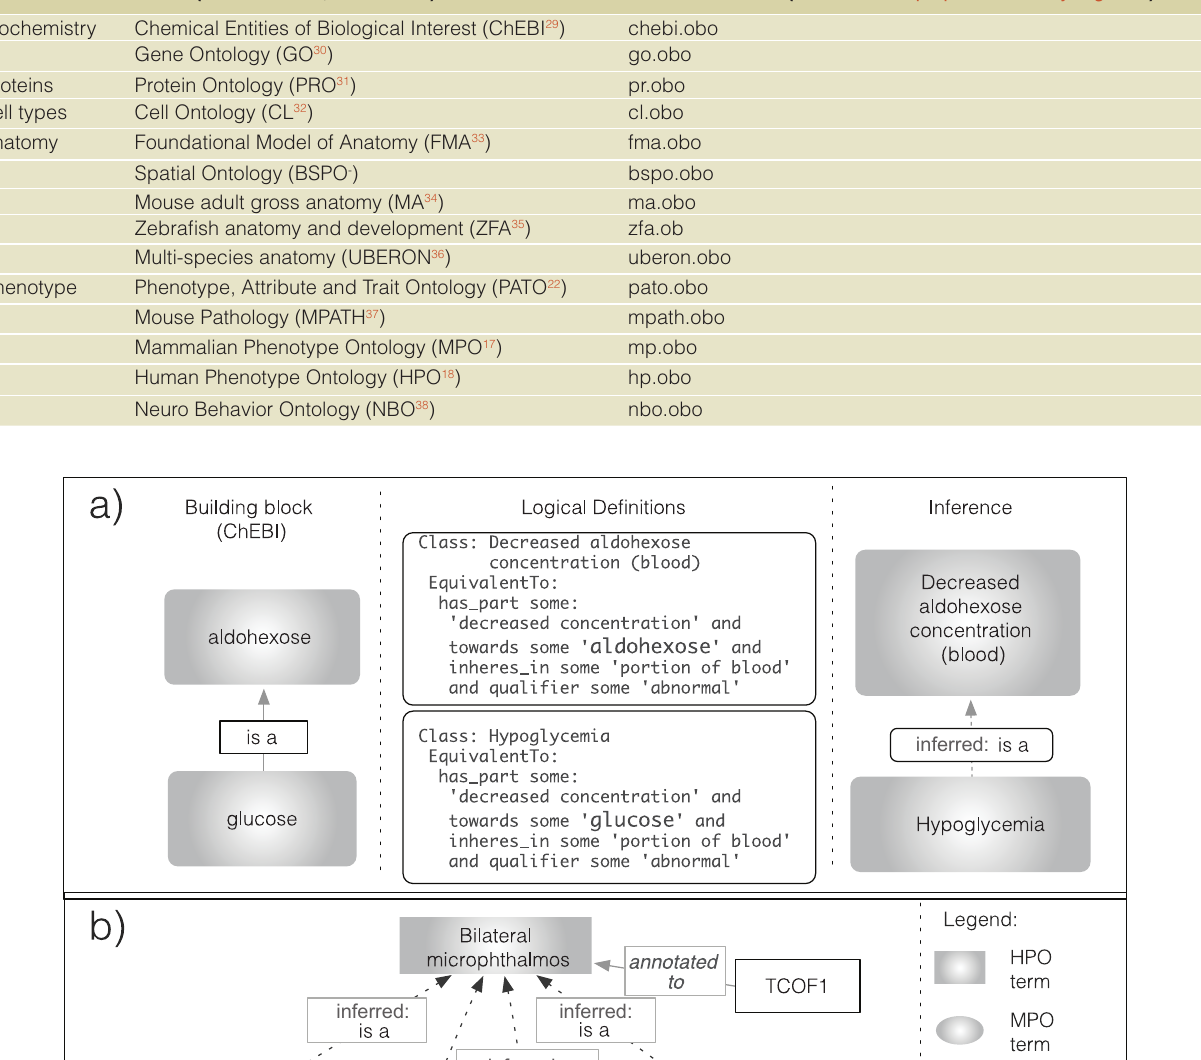
Table 1. Typical building block ontologies: here the focus lies on ontologies that can be used to represent complex classes of phenotype abnormalities in zebrafish, mouse, and human.